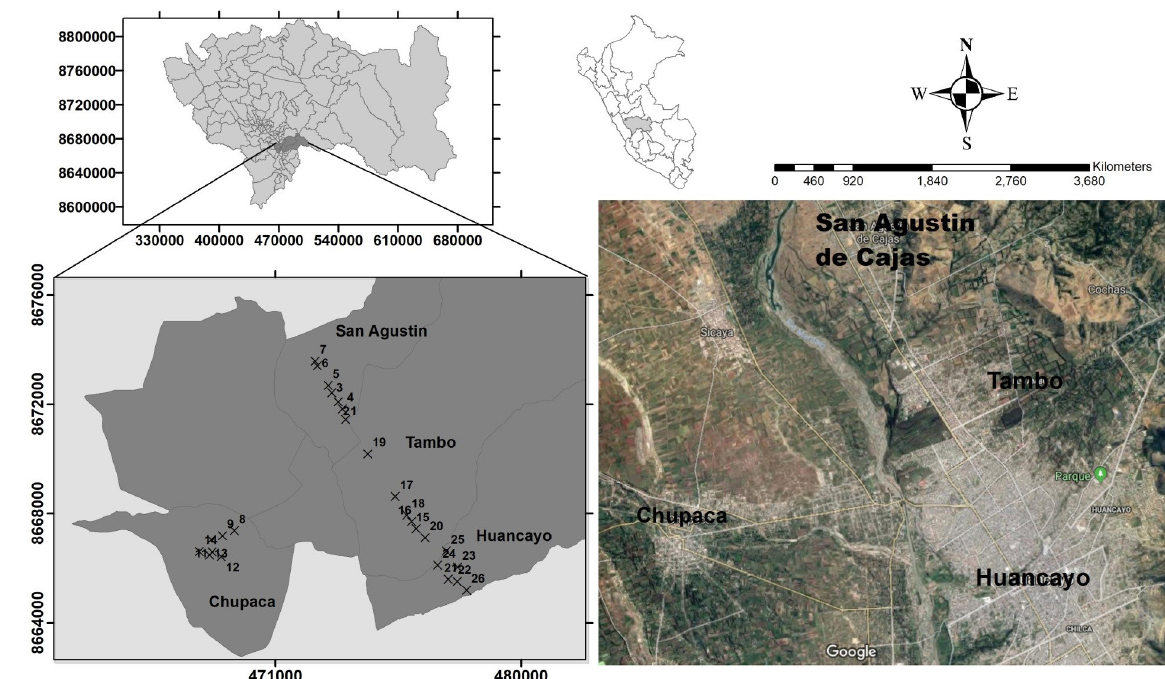
Figure 1. Biomonitoring exposure sites in the Metropolitan area of Huancayo, Peru. The Map was prepared with Arc GIS 10.0